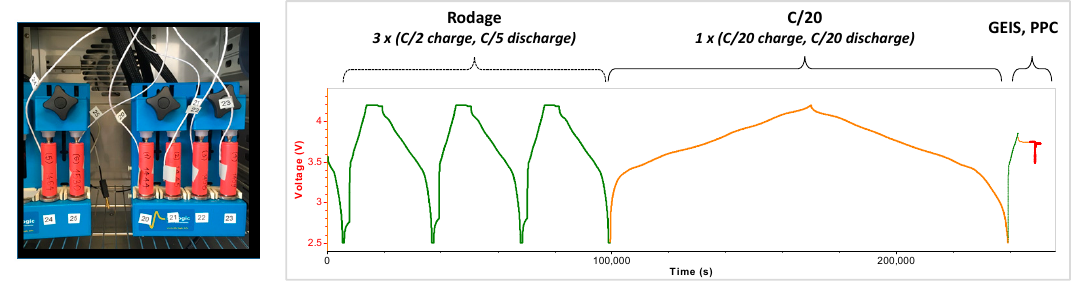
Figure 3. Setup of pristine cells in 25 °C chamber ( left ) and electrical analysis protocol ( right ).